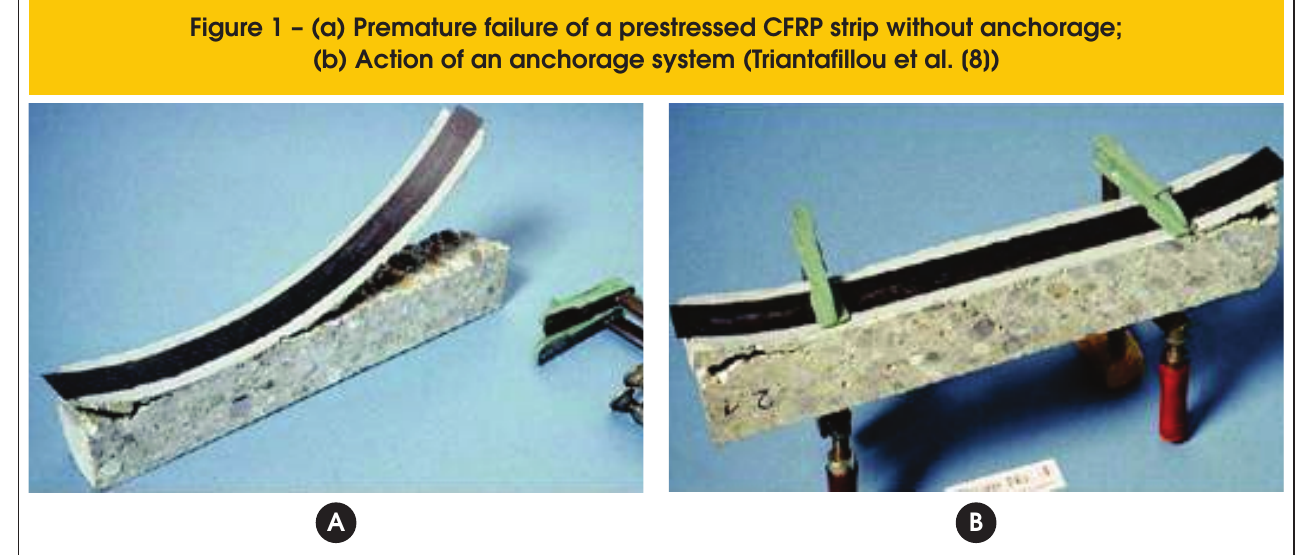
Figure 1 – (a) Premature failure of a prestressed CFRP strip without